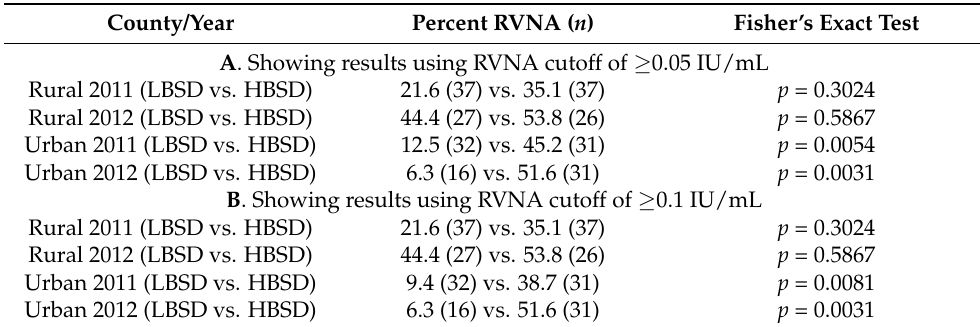
A . Showing results using RVNA cutoff of ≥ 0.05 IU/mL